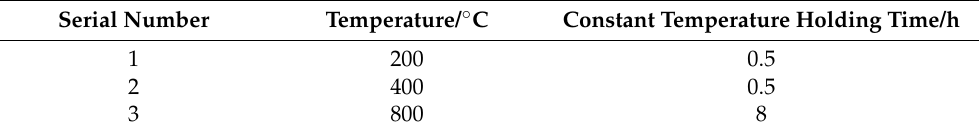
Table 1. High-temperature drying-and-calcination process for green bodies of cobalt-oxide honey- comb structures. Serial Number Temperature/ ◦ C Constant Temperature Holding Time/h